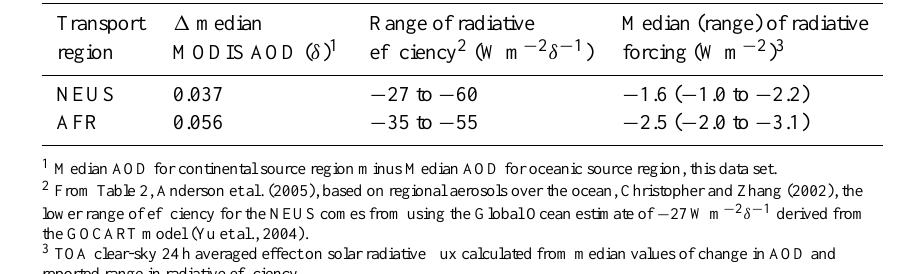
Table 6. Estimates of the change in radiative forcing associated with changes in the median aerosol optical depth (AOD) in transport from North America (NEUS) and North Africa (AFR) over Bermuda relative to the oceanic